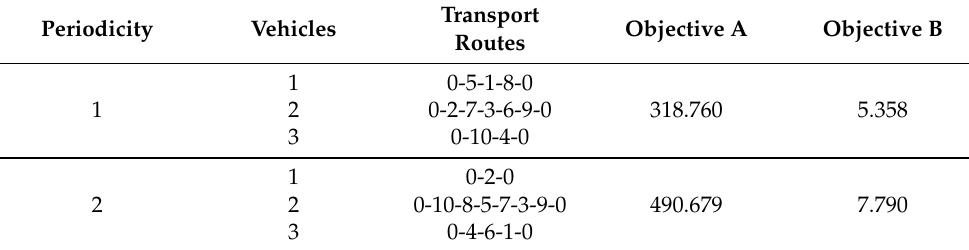
Table 10. Distribution vehicle paths and objective function